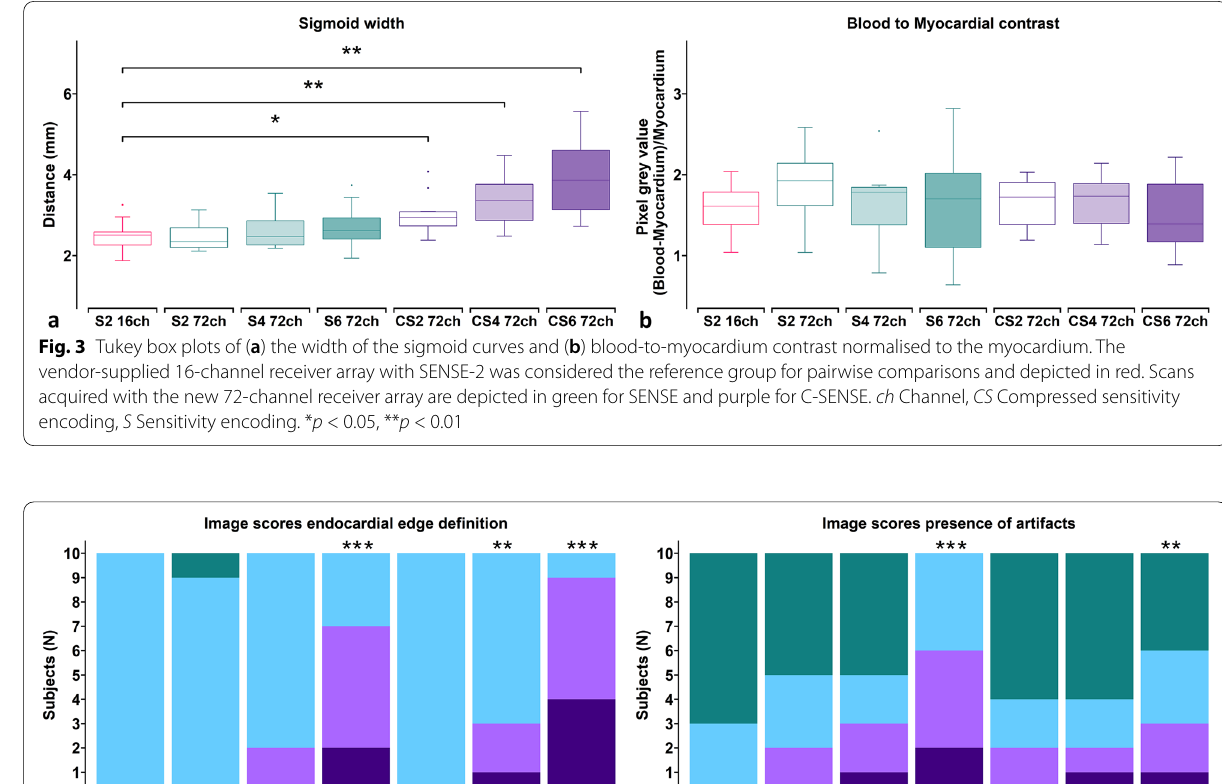
Table 3 Quantitative parameters of the left and right ventricle for all test setups